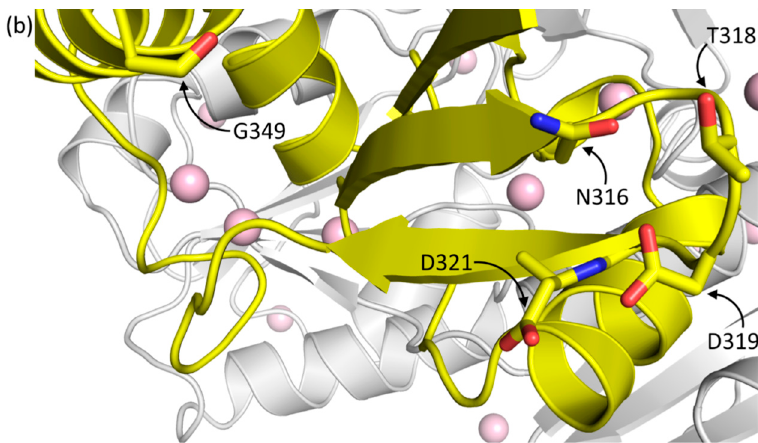
Figure 6. The glycosylation sites of high-Ca 2+ ( a ) native bovine and ( b ) recombinant bovine. The labeled residues are involved in the stabilization of the glycosylation site and the Ca 2+ -dependent stretch of residues under high-Ca 2+ conditions (Glu350 through Glu354). The dashed black lines indicate hydrogen bonds. The polypeptide backbone of native and recombinant bovine Casq1 are traced in green and yellow, respectively; and their respective dimeric partners are traced in gray. Green/yellow sticks are carbon atoms, red sticks are oxygen atoms, blue sticks are nitrogen atoms, and pink spheres are Ca 2+ ions.